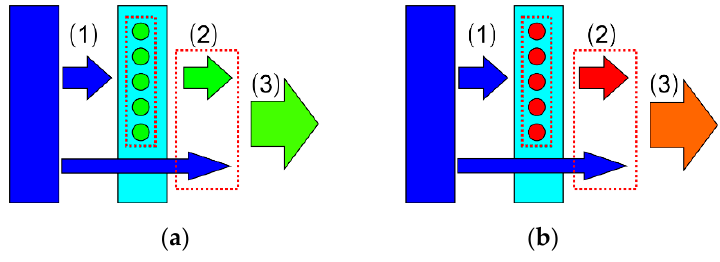
Figure 5. Light conversion optical models of ( a ) GQD LED and ( b ) RQD LED.